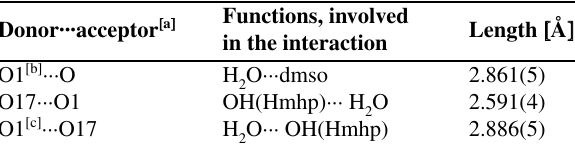
Table 3. Hydrogen-bonding interactions in the title compound.